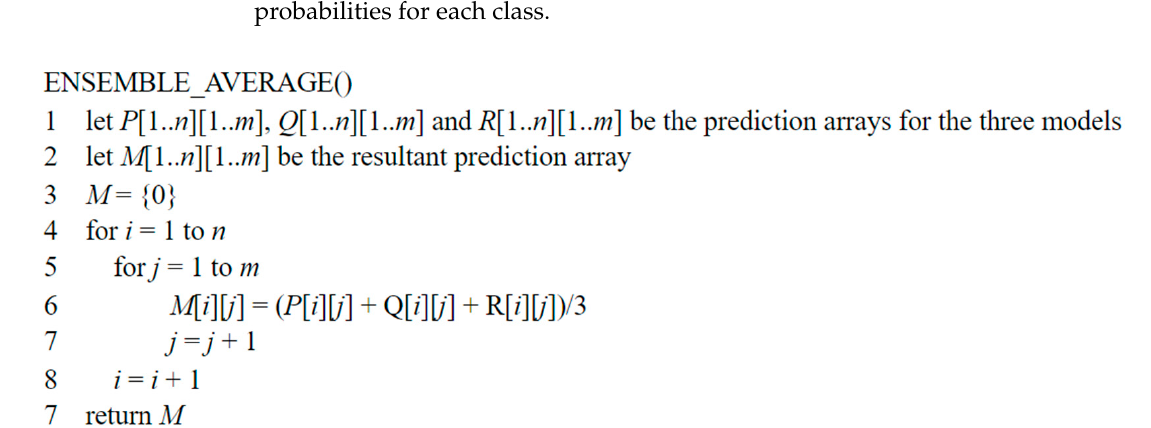
Figure 22. EfficientNet Noisy Student fundamental block. 3.5. Ensembling A disadvantage of using predictions of multiple deep learning classifiers is that they have high variance. Since each classifier is trained individually with different data being fed to it in each epoch, each of them updates their weight in isolation and thus present different results on the task of classifying the same image. A simple approach to tackle the